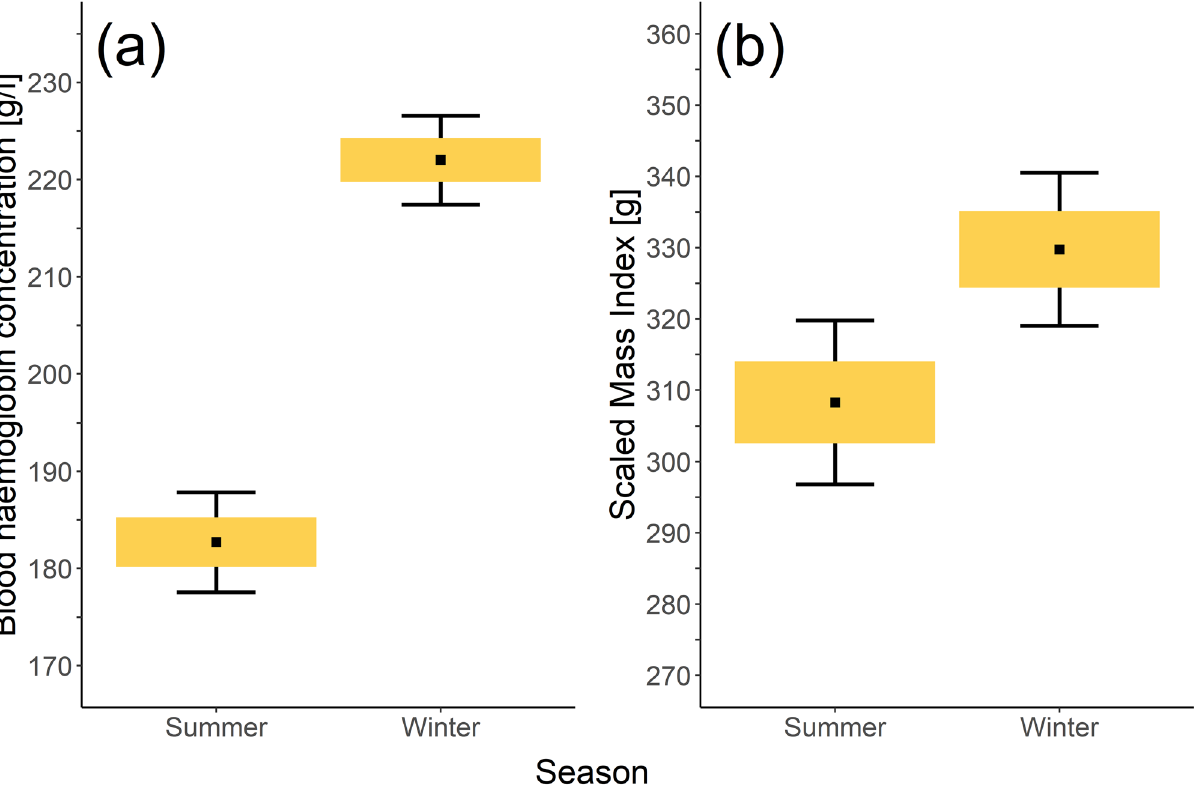
Figure 3. Comparison of ( a ) blood haemoglobin concentration and ( b ) Scaled Mass Index of feral pigeons in summer and winter. Central points indicate mean value, boxes and whiskers represent standard error and 95% confidence intervals, respectively.